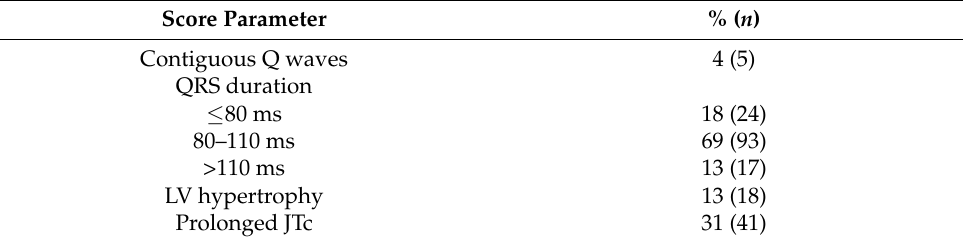
Table 2. Composition of ECG score.